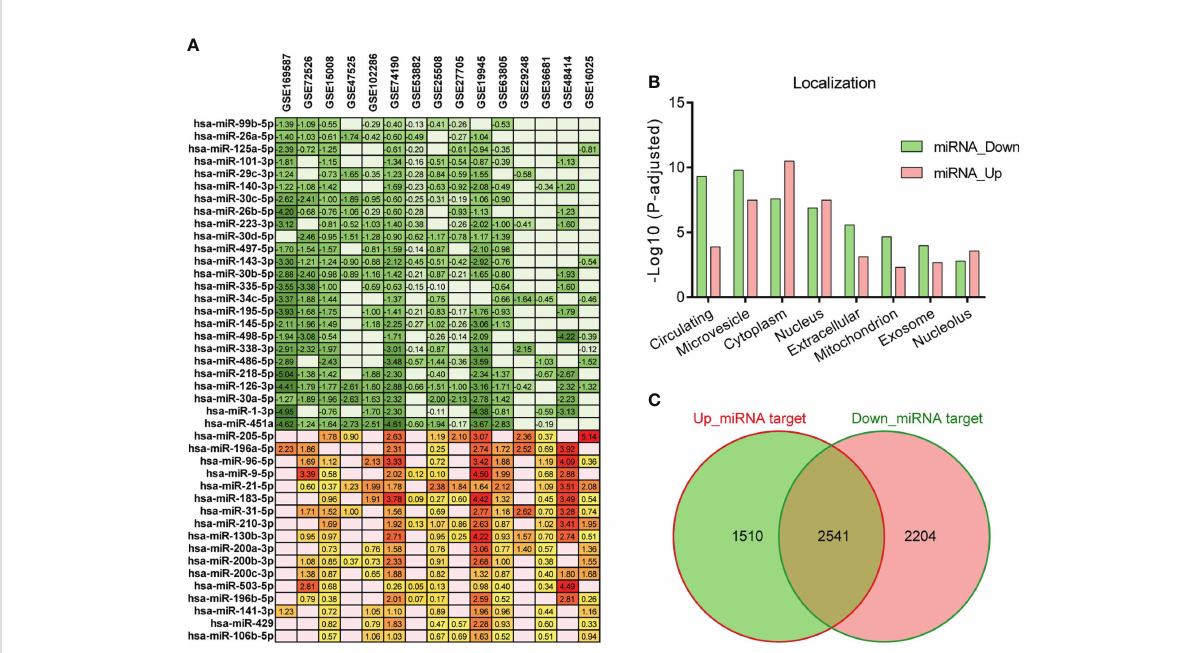
FIGURE 1 Differentially expressed miRNAs in LC. (A) Differentially expressed miRNAs ( p < 0.05) in tumor compared to normal in at least nine out of fi fteen LC datasets. The number represents the value of log2FC determined by GEO2R analysis, and the red/green scale boxes represent the up- or down-regulated miRNAs. (B) Subcellular localization of the selected miRNAs was obtained by RNALocate. (C) Target genes of the up- and down-regulated miRNAs were predicted by ENCORI. The overlapping parts were deleted from the predicted gene lists and only considered the two fl anking